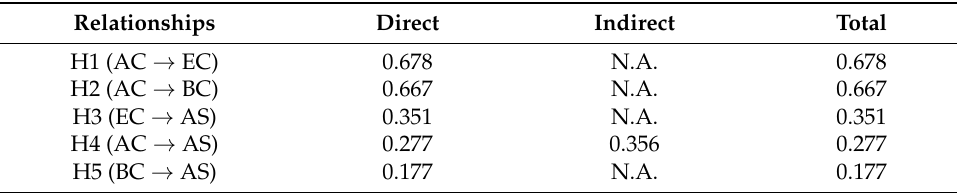
Table 4. Direct, indirect, and total